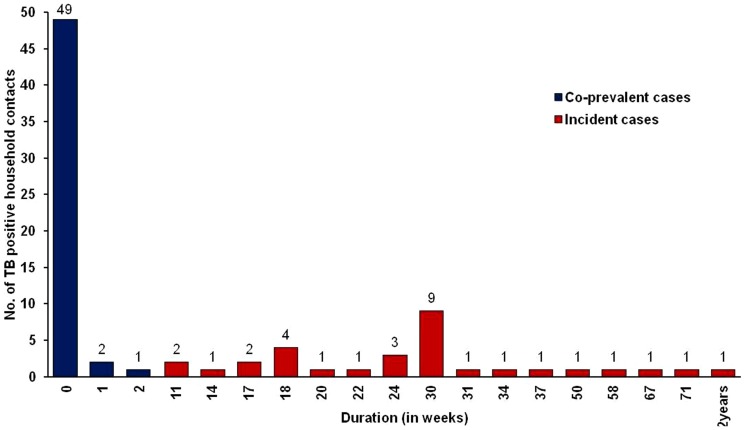
Time of detecting co-prevalent (Cp) and incident (Ip) secondary tuberculosis cases.